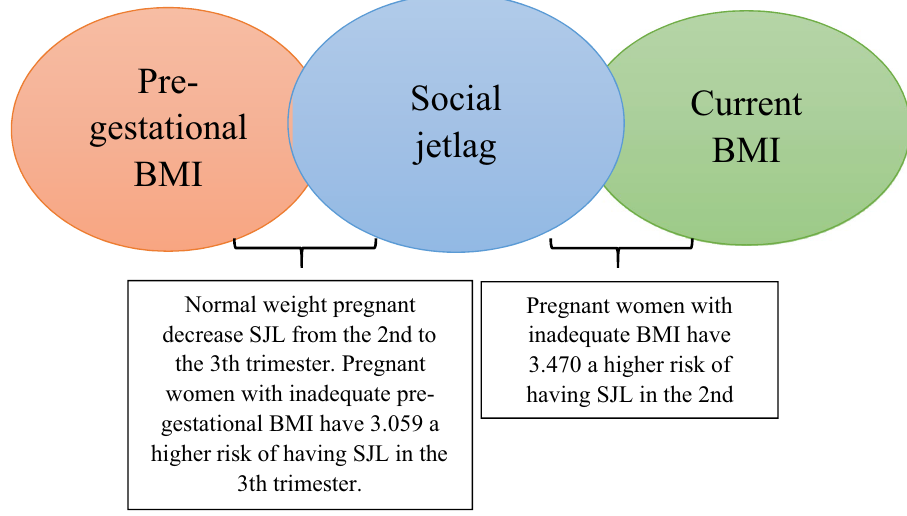
Figure 6. Relationship between social jetlag, pre-gestational BMI and current